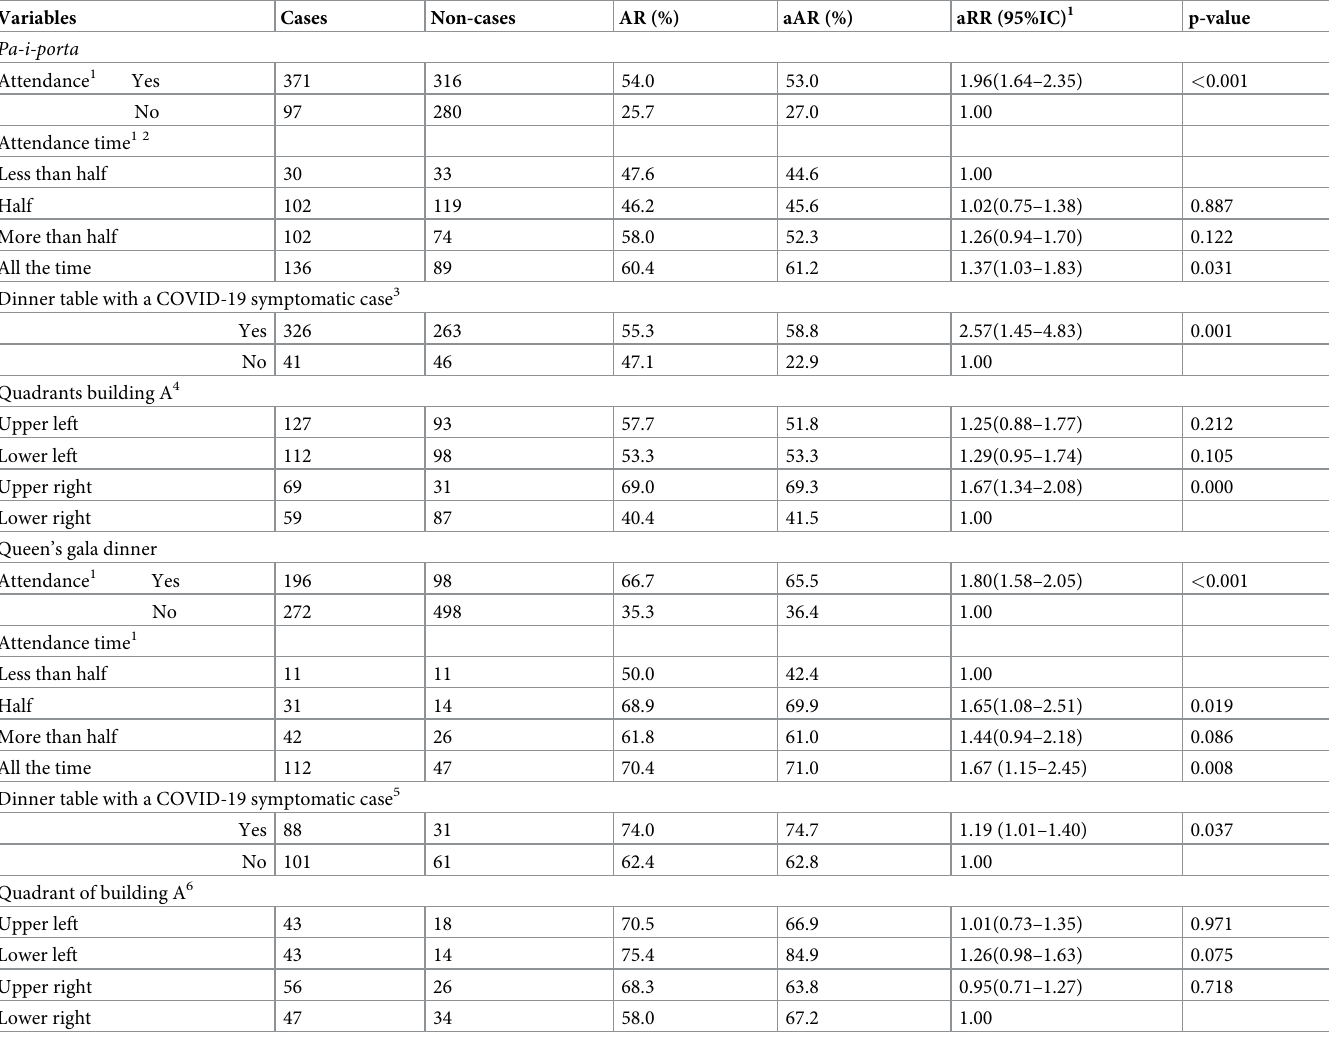
Table 8. Sensitivity analysis. Participants with laboratory tests of SARS-CoV-2 and the pa-i-porta and Queen’s gala dinner mass gathering event (MGE) attendance, attack rate (AR), adjusted AR (aAR), and adjusted (aRR). Confidence interval (CI). From March 6 to 31, 2020,